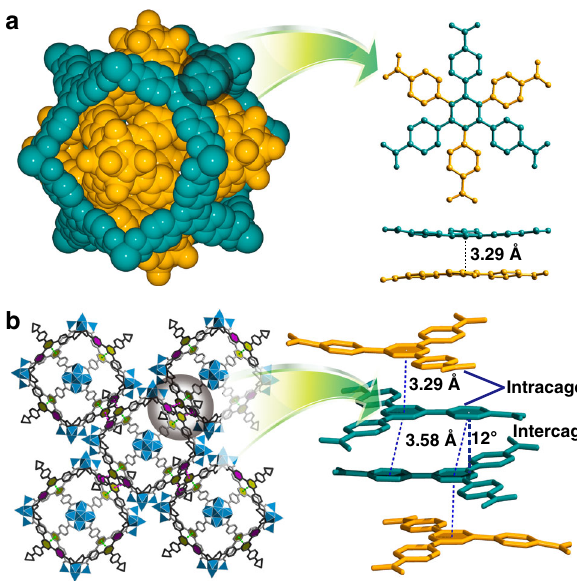
Fig. 3 Supramolecular interactions of 1. a A face-to-face π – π interaction between the inner and outer cages, where most of the ring – plane area overlaps. Atoms of the inner and outer cages are marked in orange and cyan, respectively. b A π – π interaction between the neighboring double- shell cages, where the rings are parallel